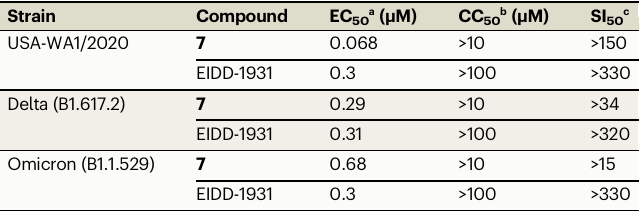
Table 3 | Virus Yield Reduction Data for Compound 7 Against Three Variants of SARS-CoV-2 in Caco-2 Cells